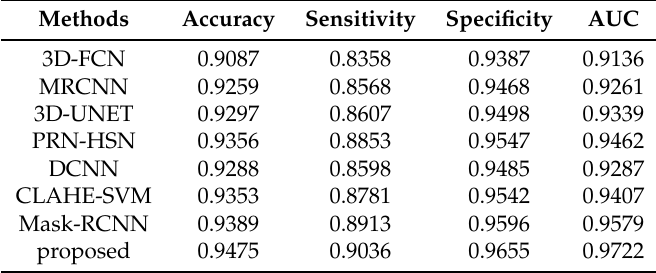
Table 10. Quantitative results associated with different nodule detection methods on TianChi dataset.